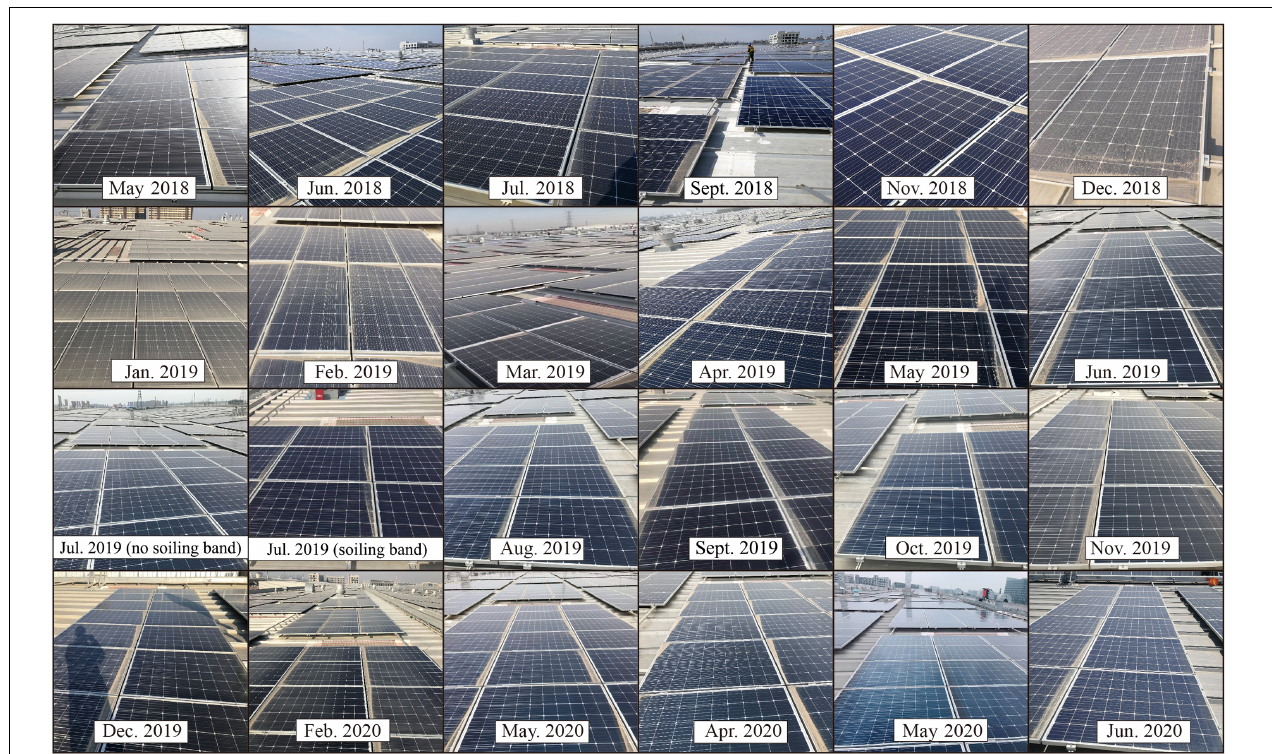
FIGURE 2 | Soiling strip photographs of an industrial and commercial metal rooftop PV power station in Xi’an city from May 2018 to June